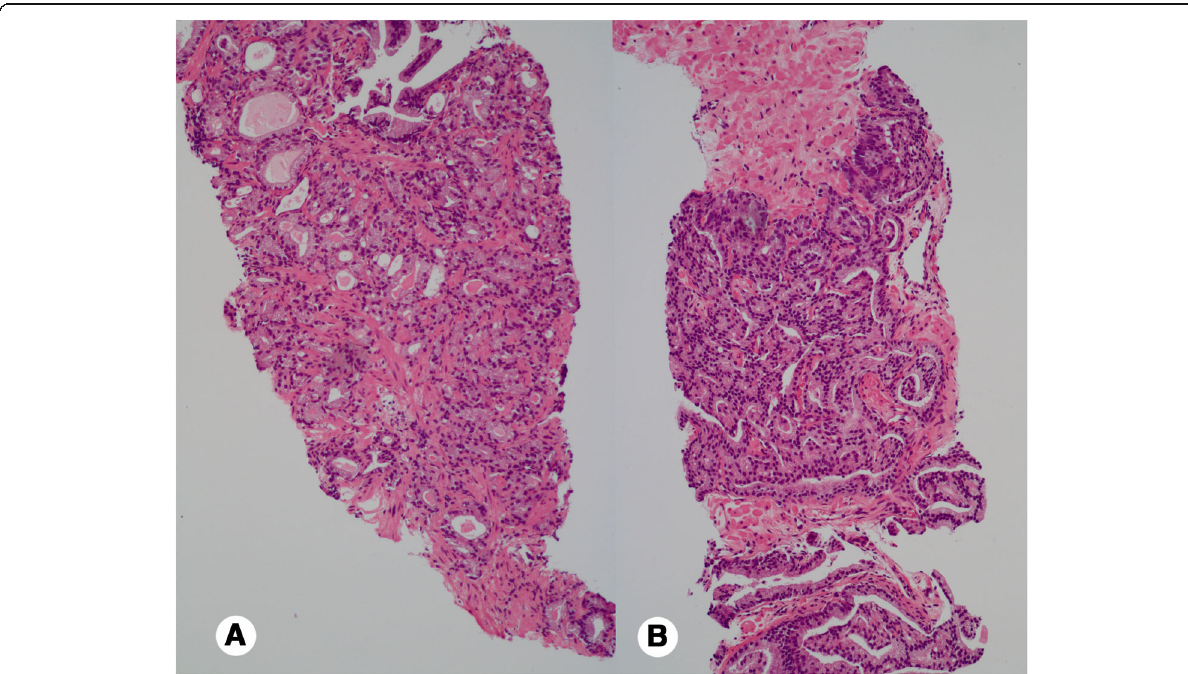
Fig. 1 Common patterns of Gleason pattern 4 in acinar adenocarcinoma of the prostate. a poorly differentiated glands (HE, 40×) and cribriform morphology (HE,